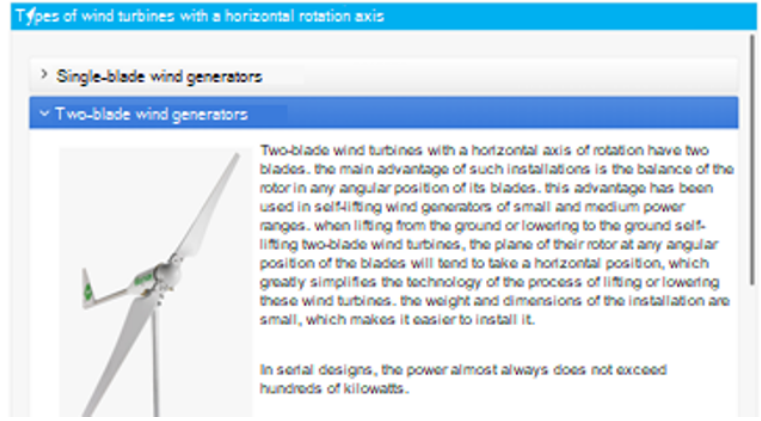
Fig. 4. Typical interactivity